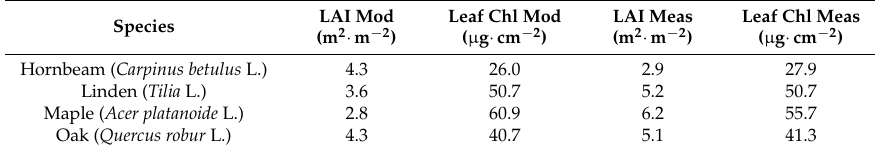
Table 3. Modeled and measured LAI and leaf chlorophyll concentration ( µ g ¨ cm ´ 2 ) for Hornbeam ( Carpinus betulus L.), Linden ( Tilia L.), Maple ( Acer platanoide L.) and Oak ( Quercus robur L.). Species Hornbeam ( Carpinus betulus